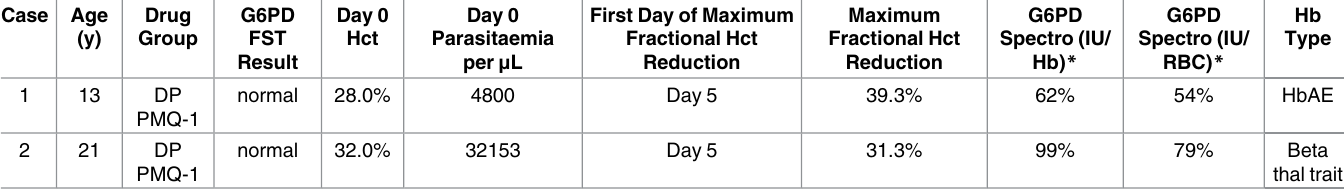
Table 4. Characteristics of two G6PD heterozygous participants who required